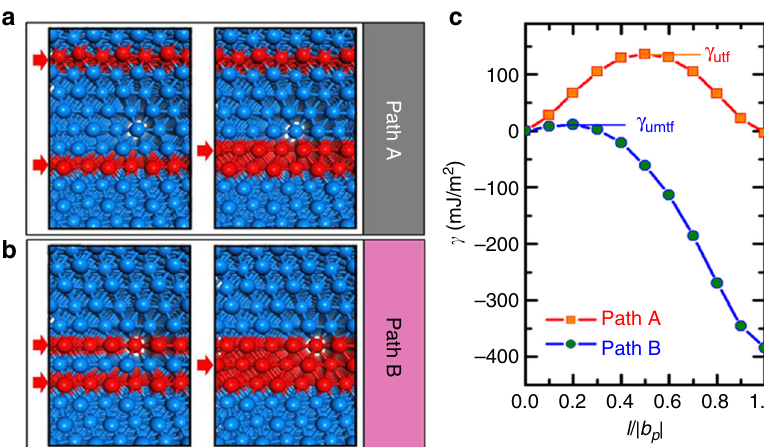
Fig. 4 Density functional theory calculations of twinning energy landscape. a Atomic structures of twin nucleation in the classical model (path A). In the initial state (the left image), the fi rst two SFs are separated by fi ve atomic layers; in the fi nal state (the right image), a third SF forms next to a SF. b Atomic structures of twin nucleation in the new model (path B). In the initial state (the left image), the fi rst two SFs are separated by one atomic layer; in the fi nal state (the right image), a third SF forms between the fi rst two SFs. In a , b , the red atomic planes indicated the SF layers. c The calculated energy change γ as a function of the sliding displacement l (normalized by the magnitude of twin partial slip b p ) at the SF layer for paths A and B. The energies of the initial states in a , b are set to